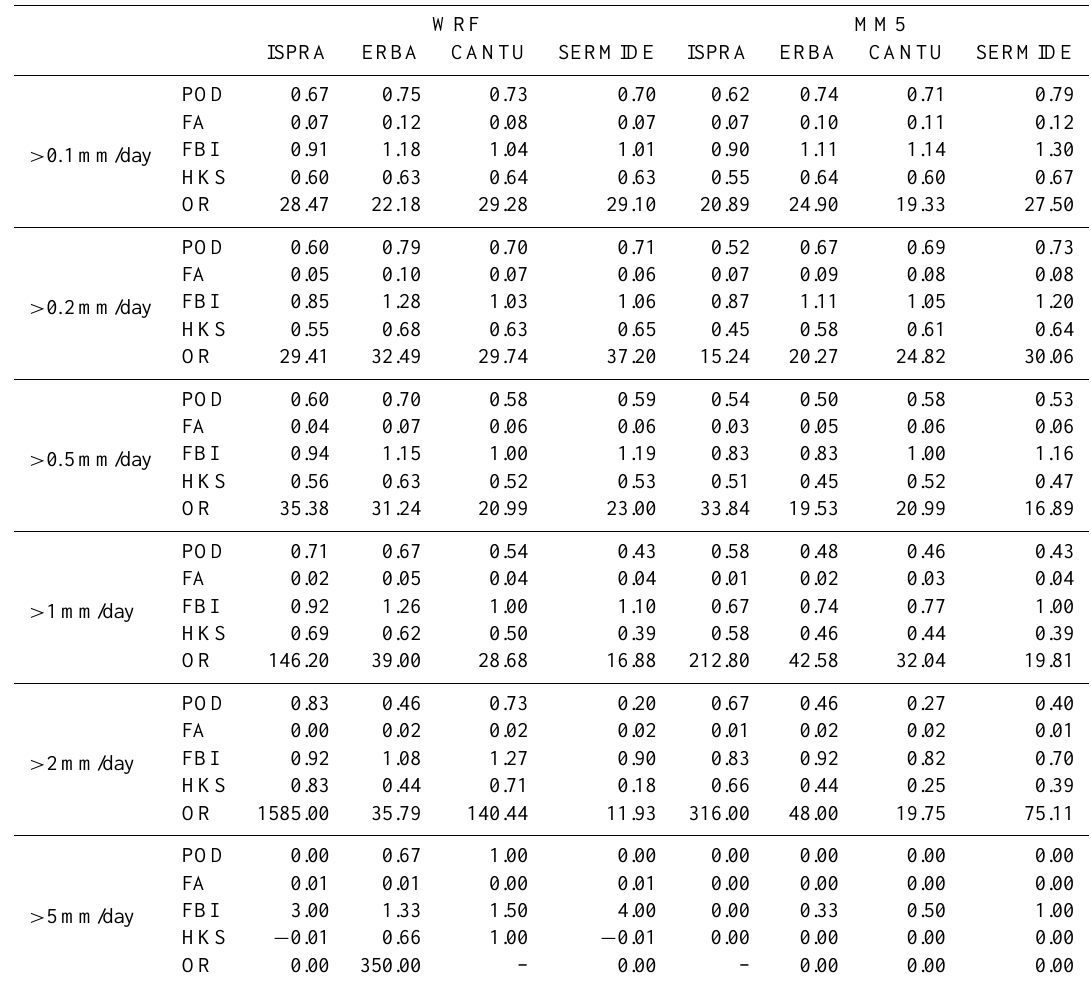
Table 3e. Hit rate statistics for the rain data, the whole of the year 2005. WRF MM5 ISPRA ERBA CANTU SERMIDE ISPRA ERBA